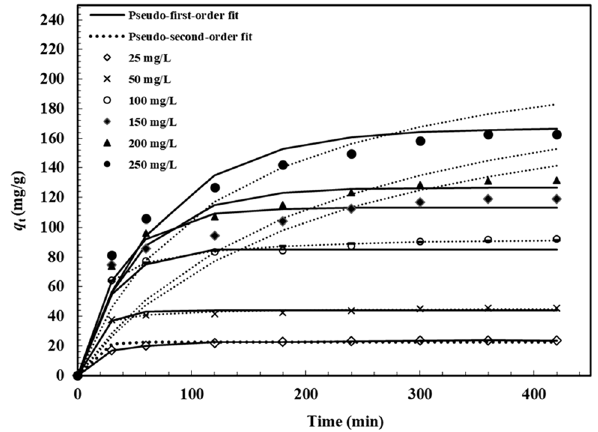
Fig. 7 Nonlinear plots of pseudo-first-order and pseudo-second-order models for MB adsorption onto BNH-CM at 40